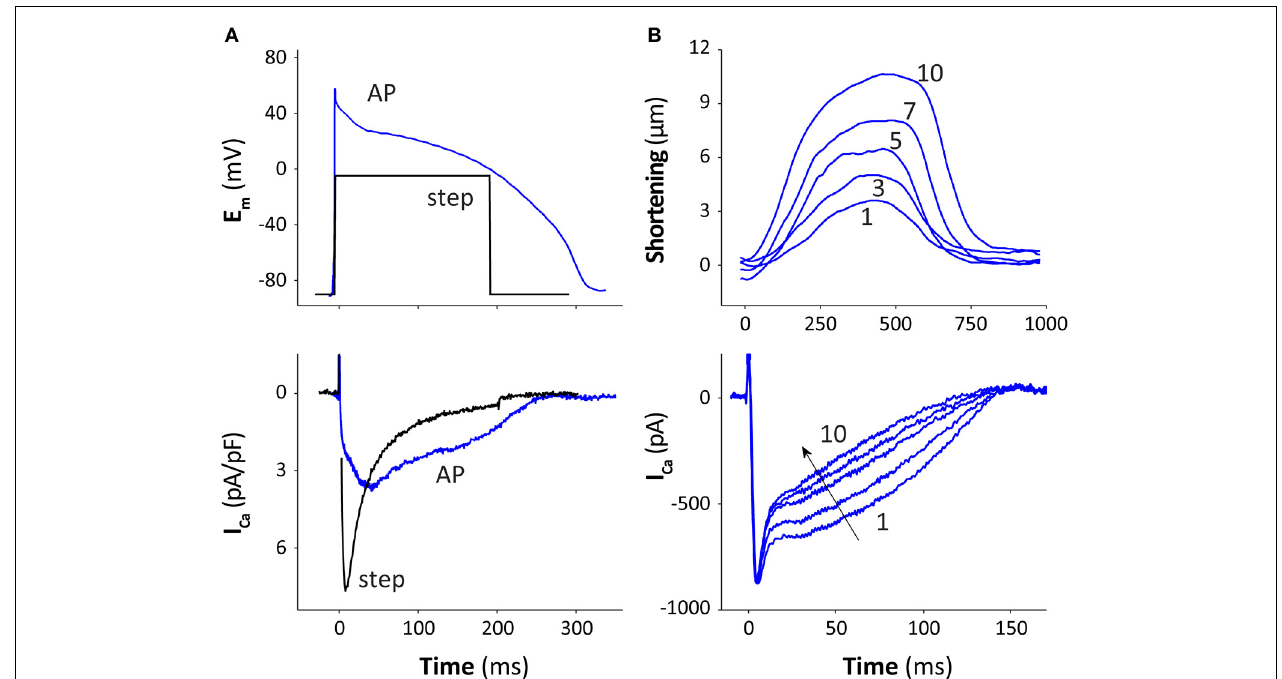
FIGURE 2 | I Ca inactivation during theAP.(A) Rabbitventricular myocytes (at 25 ◦ C) were voltage-clamped with either a square voltage step or an AP waveform (measured from 5 other cells under physiological conditions). All other currents were blocked, e.g., by replacement of K + with Cs + and Na + with TEA (inside and out) and cells were dialyzed with 10mM EGTA to prevent